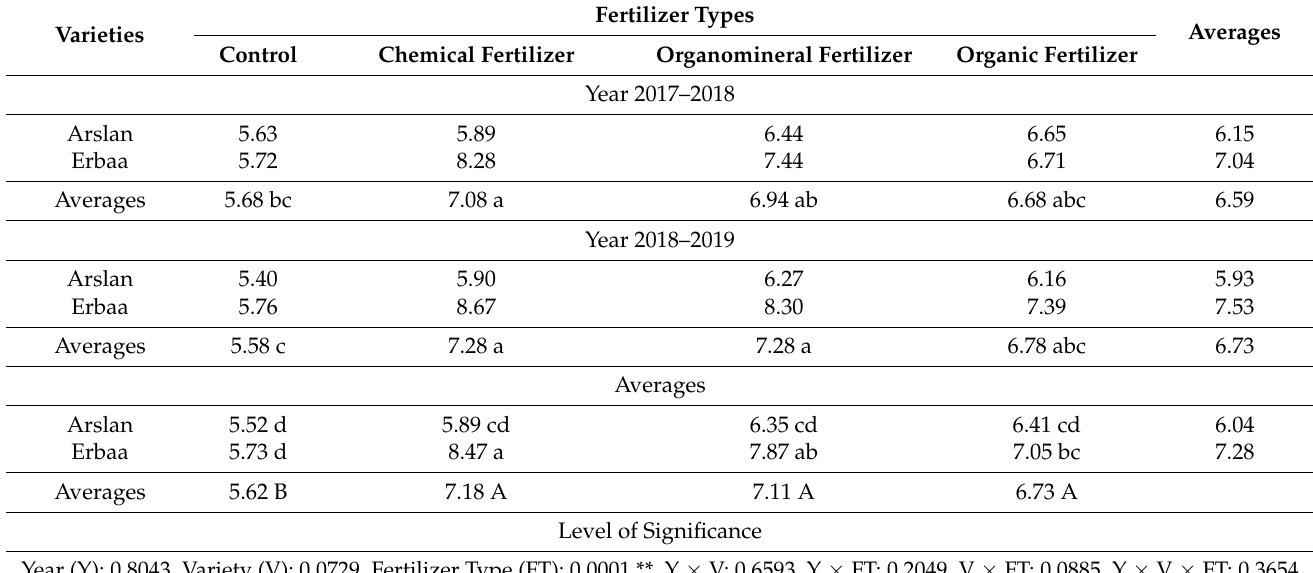
Table 5. The effect of fertilizer types on the number of umbelets per umbel in coriander varieties (pieces) 1 . Varieties